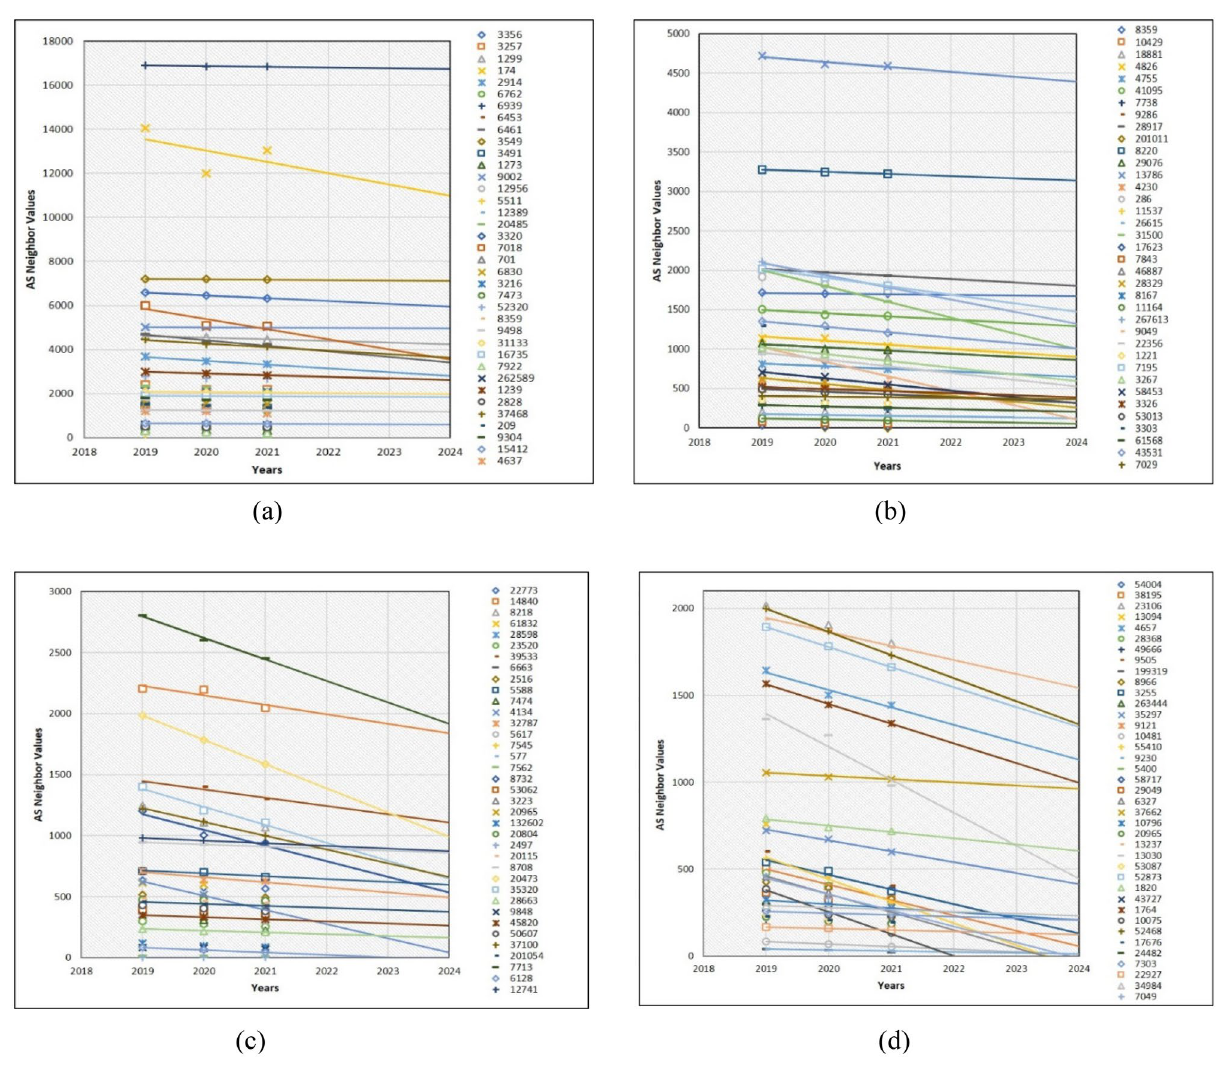
Figure 11. Prediction of 150 L-ISP-type AS neighbor